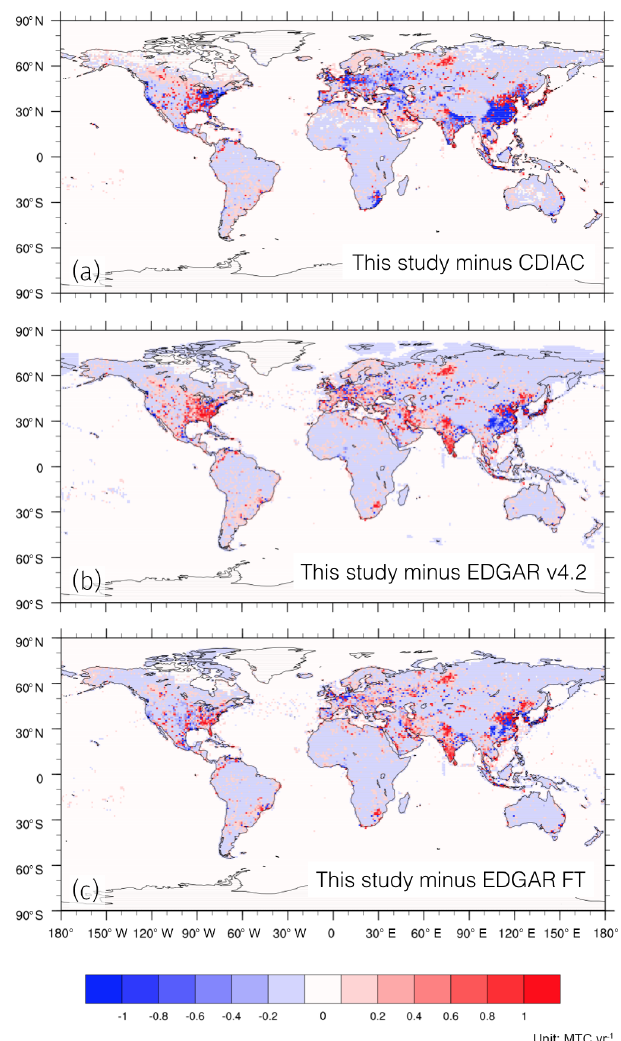
Figure 7. ODIAC minus other emissions data differences. CDIAC (b) and the two versions of EDGAR (v4.2, c ; and v4.2 FastTrack, d ). The units are million tons of carbon per year per cell (1 × 1 ◦ ). Note that the differences are defined as ODIAC (this study) minus others. The histograms of the differences are also presented in Fig.